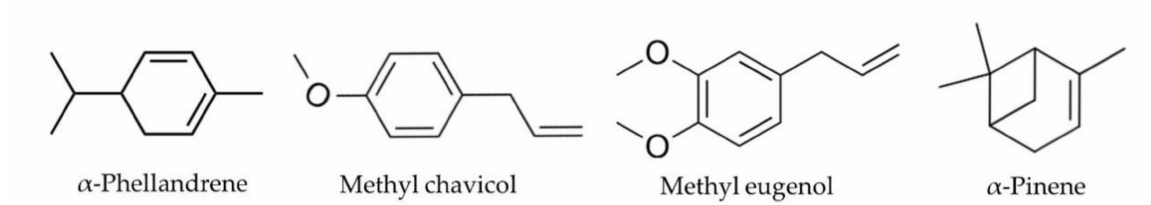
Figure 2. Main compounds of the essential oil from male and female specimens of Hedyosmum racemosum .